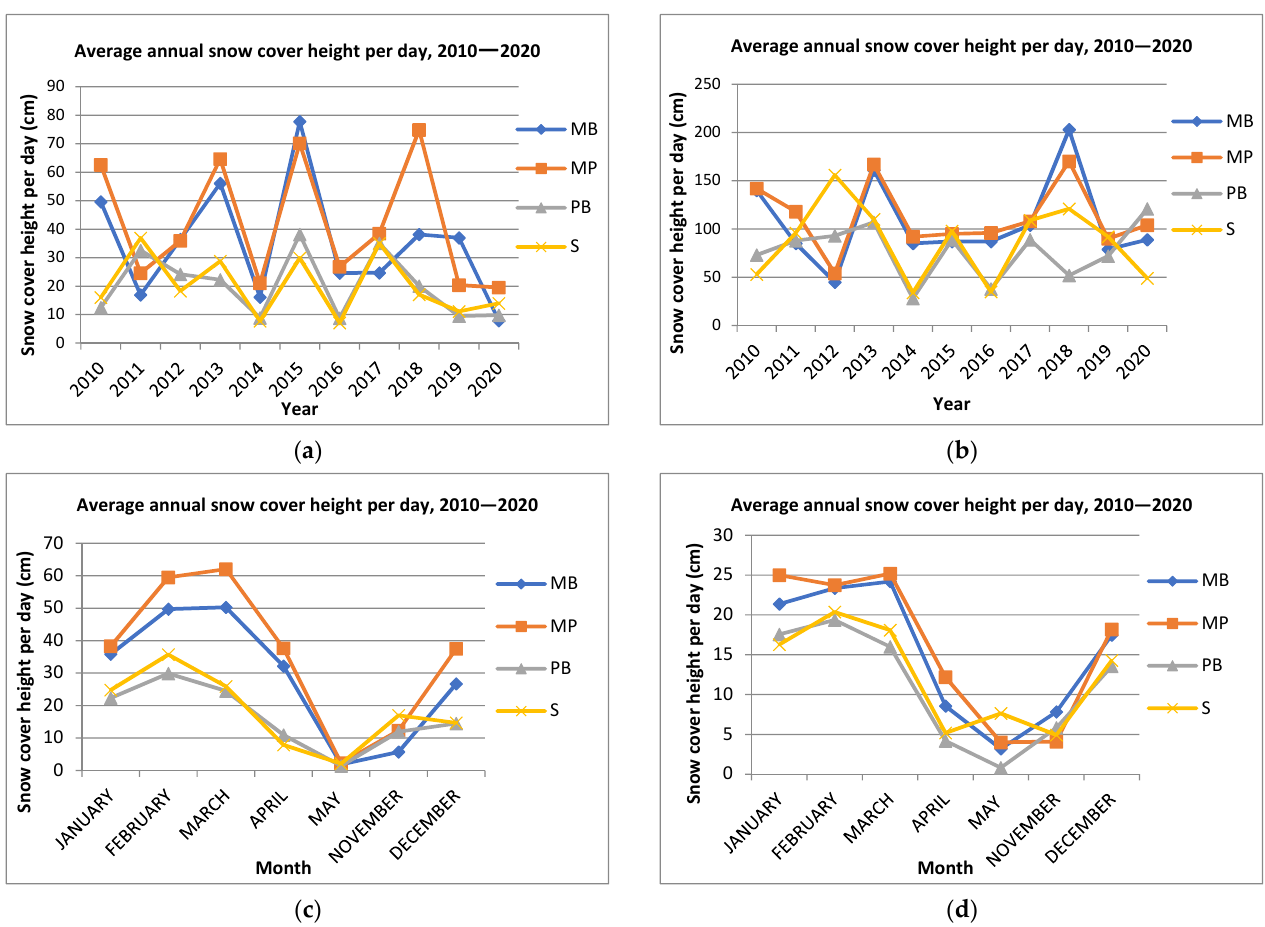
Figure 3. ( a ) Average annual snow cover height per day, period 2010–2020; ( b ) Days with snow cover per year 2010–2020; ( c ) Average monthly snow cover height per day, 2010–2020; ( d ) Days with snow cover per month; abbreviation for weather stations: MB = Monte Bove Sud; MP = Monte Prata; PB = Pintura di Bolognola; S = Sassotetto. Table 3. Mann-Kendall seasonal test results, the alpha value has been set to 0.05; in bold the sig- nificant p -values; ( sch ), Average monthly snow cover height per day, days with snow cover per month (sc d ) for the weather stations ( MB , MP , PB , S ).